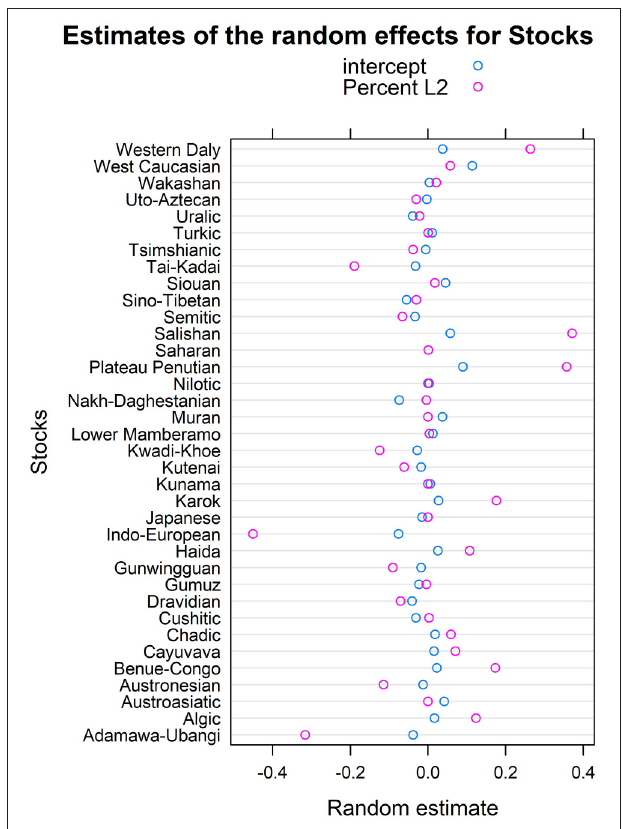
FIGURE 7 | Estimates of the random effects for Stock in the reduced model SYNTHESIS.L2+.